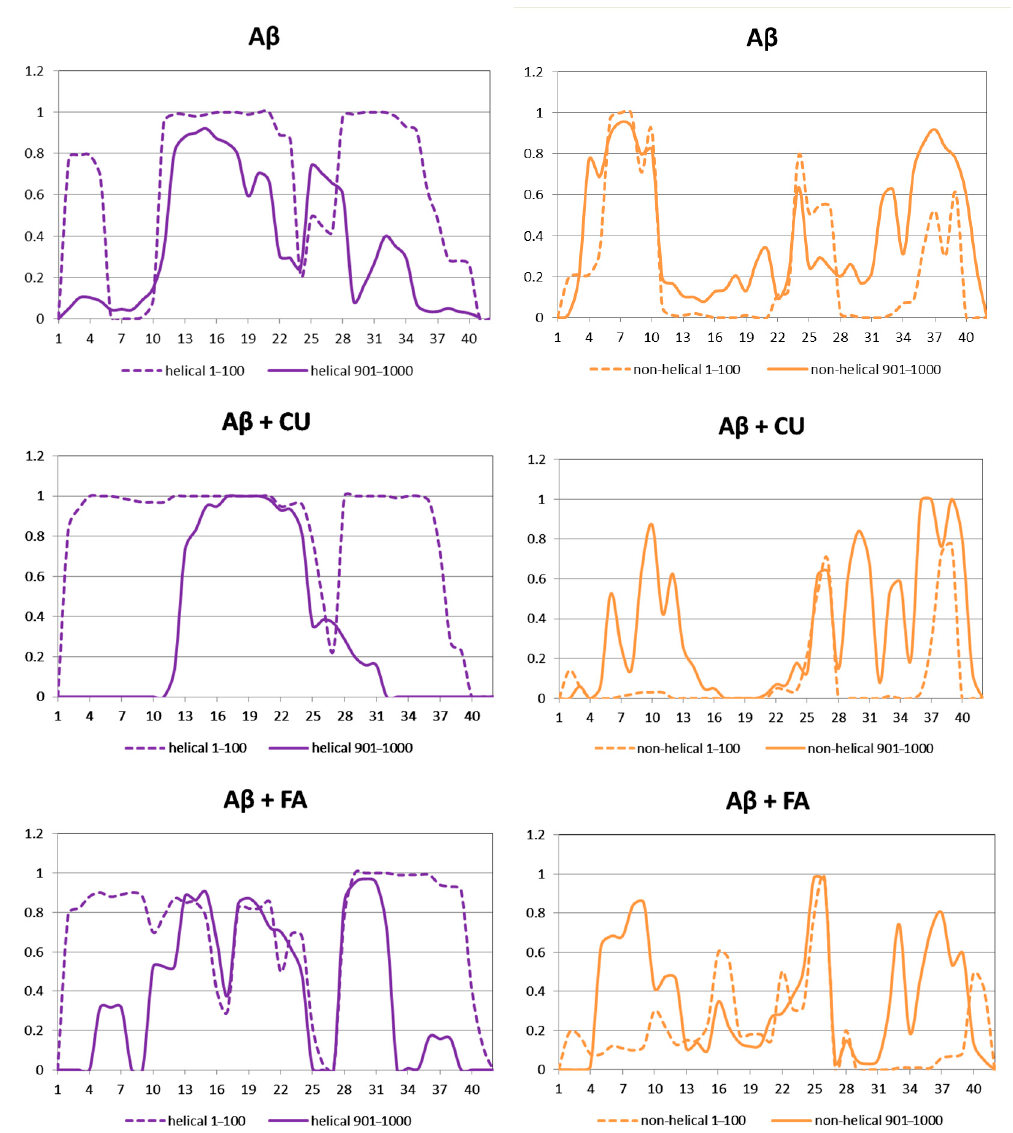
Figure 5. Propensities of helical and non-helical structures of the modelled systems averaged over the initial 100 ns (dash lines) and the final 100 ns (solid lines) of the production